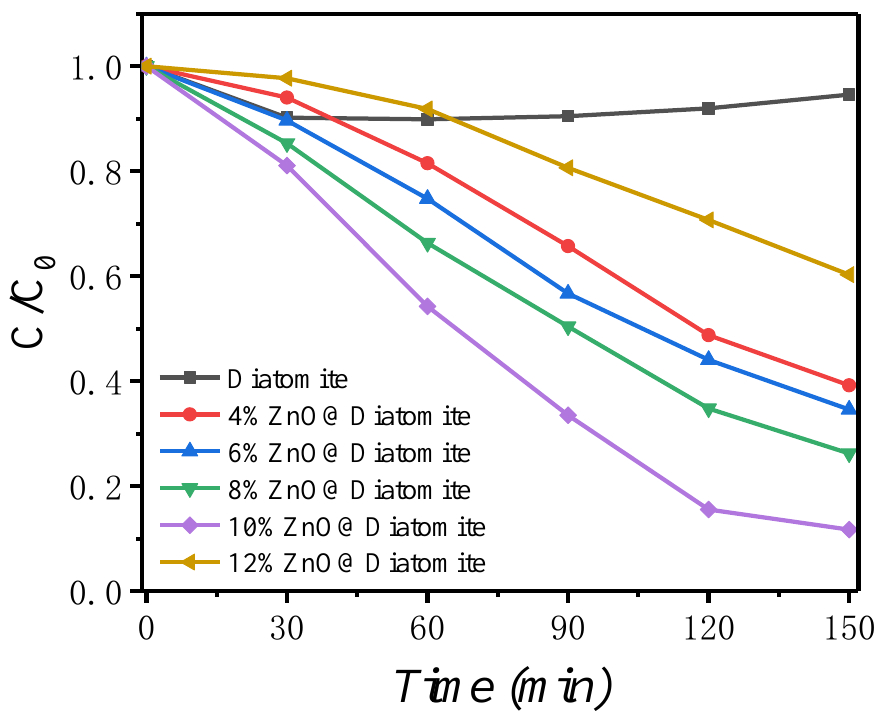
Figure 10. MB photodegradation over various catalysts under visible light.